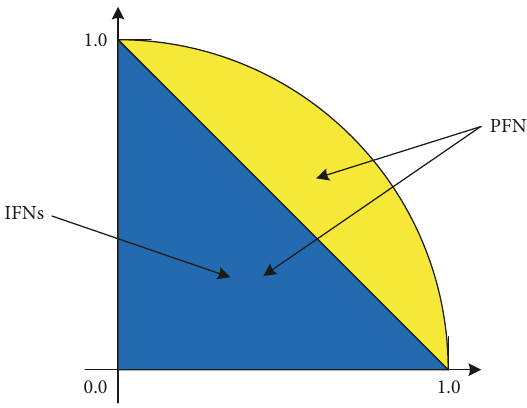
Figure 1: Possible distribution areas for IFNs and